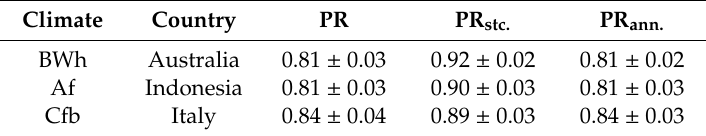
Table 2. Performance ratio of p-Si systems and their standard deviation by climate.